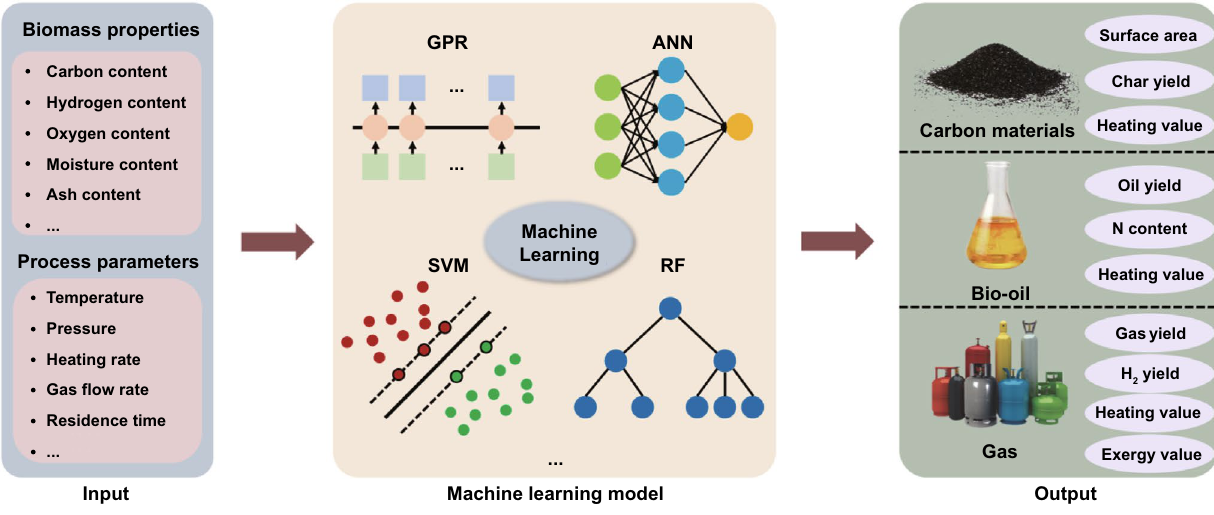
Fig. 9 Application of machine learning in modeling of biomass thermochemical conversions. GPR: Gaussian process regression; SVM: support vector machine; RF: random forest (RF); ANN: artificial neural